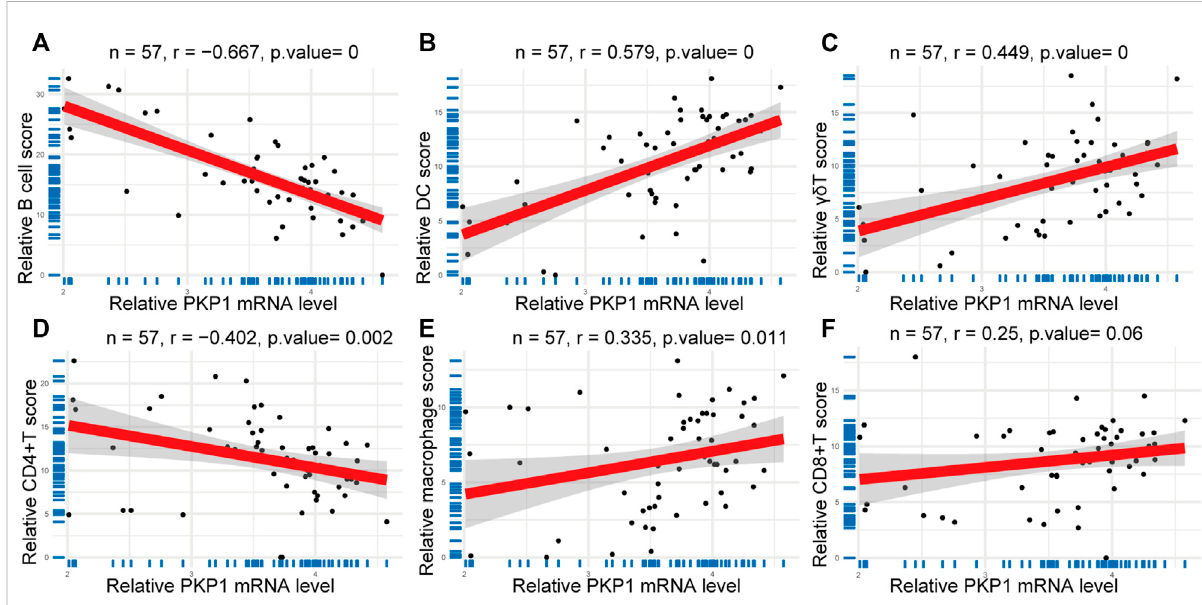
FIGURE 7 Correlations between PKP1 and immune cells. (A – E) The expression of relative PKP1 mRNA was signi fi cantly correlated with B cells, DCs, γδ Ts, CD4 + T cells, and macrophages. (F) A representative that the expression of relative PKP1 mRNA had no signi fi cant correlation with CD8 + T cells, monocytes, NK cells, neutrophils, and NKT cells. p values were calculated by Spearman ’ s rank correlation test with a statistical signi fi cance of p <